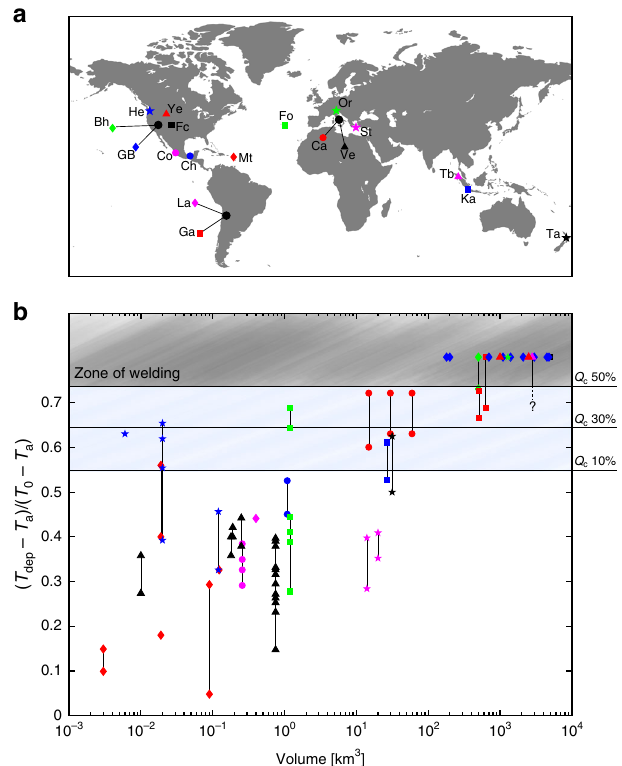
Fig. 4 Collection of emplacement temperature data from historical column collapse-generated PDC deposits as a function of their respective estimated volume. a Volcanoes from which literature data were selected around the world. Abbreviations of volcano or ignimbrite names are: Bh = Bishop Tuff; Ca = Colli Albani; Ch = El Chichón; Co = Colima; Fc = Fish Canyon Tuff; Fo = Fogo; Ga = Cerro Galán; GB = Great Basin Ignimbrite province; He = Mt. St. Helens; Ka = Krakatau; La = Lascar; Mt = Montserrat; Or = Ora ignimbrite; St = Santorini; Ta = Taupo; Tb = Toba; Ve = Vesuvius; Ye = Yellowstone. Symbols correspond to each eruptive center. b The emplacement temperatures T dep are normalized by the average eruptive temperatures T 0 , which are determined either from experimental data